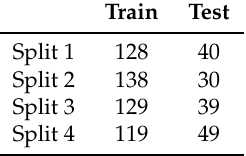
Table 5. Image counts for train/test sets used to train and evaluate the deep-learning based algorithm.